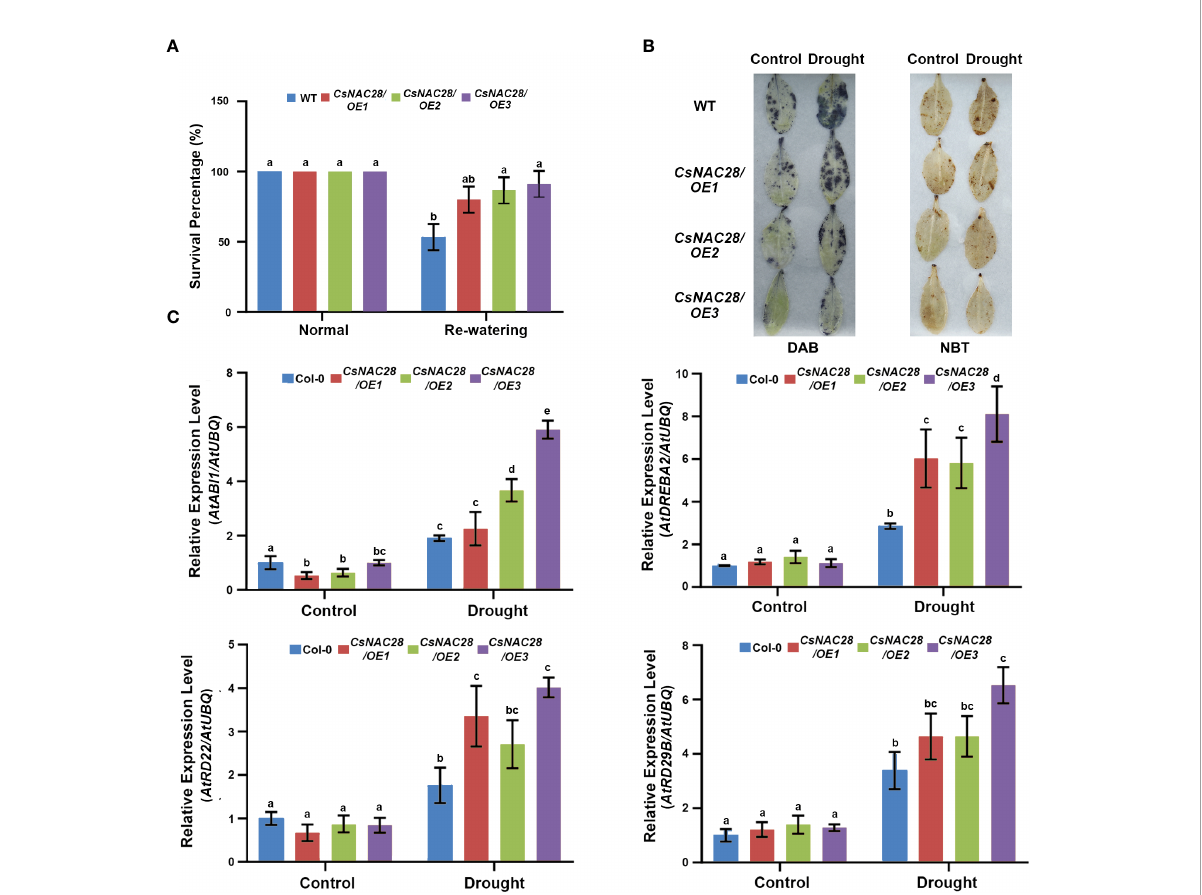
FIGURE 9 Overexpression of CsNAC28 improves drought stress tolerance in transgenic Arabidopsis. (A) Survival rates of the WT and transgenic lines at 7d of re-water. (B) Histochemical detection of hydrogen peroxide (H 2 O 2 ) and superoxide (O 2 − ) using DAB staining and NBT staining. (C) The relative expression of four abiotic stress-responsive genes in transgenic lines and the WT under normal and drought stress conditions. Error bars indicate the SD of three biological